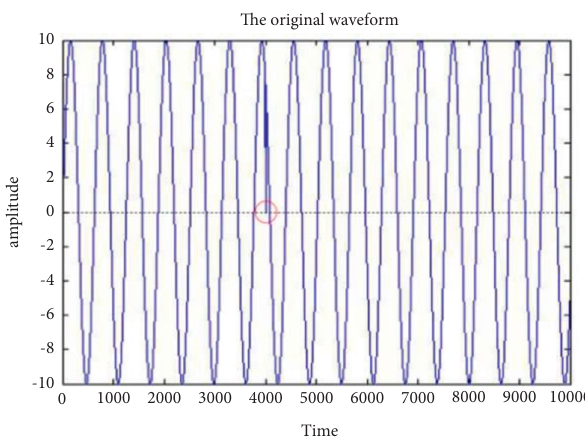
Figure 2: Waveform of the sample data.